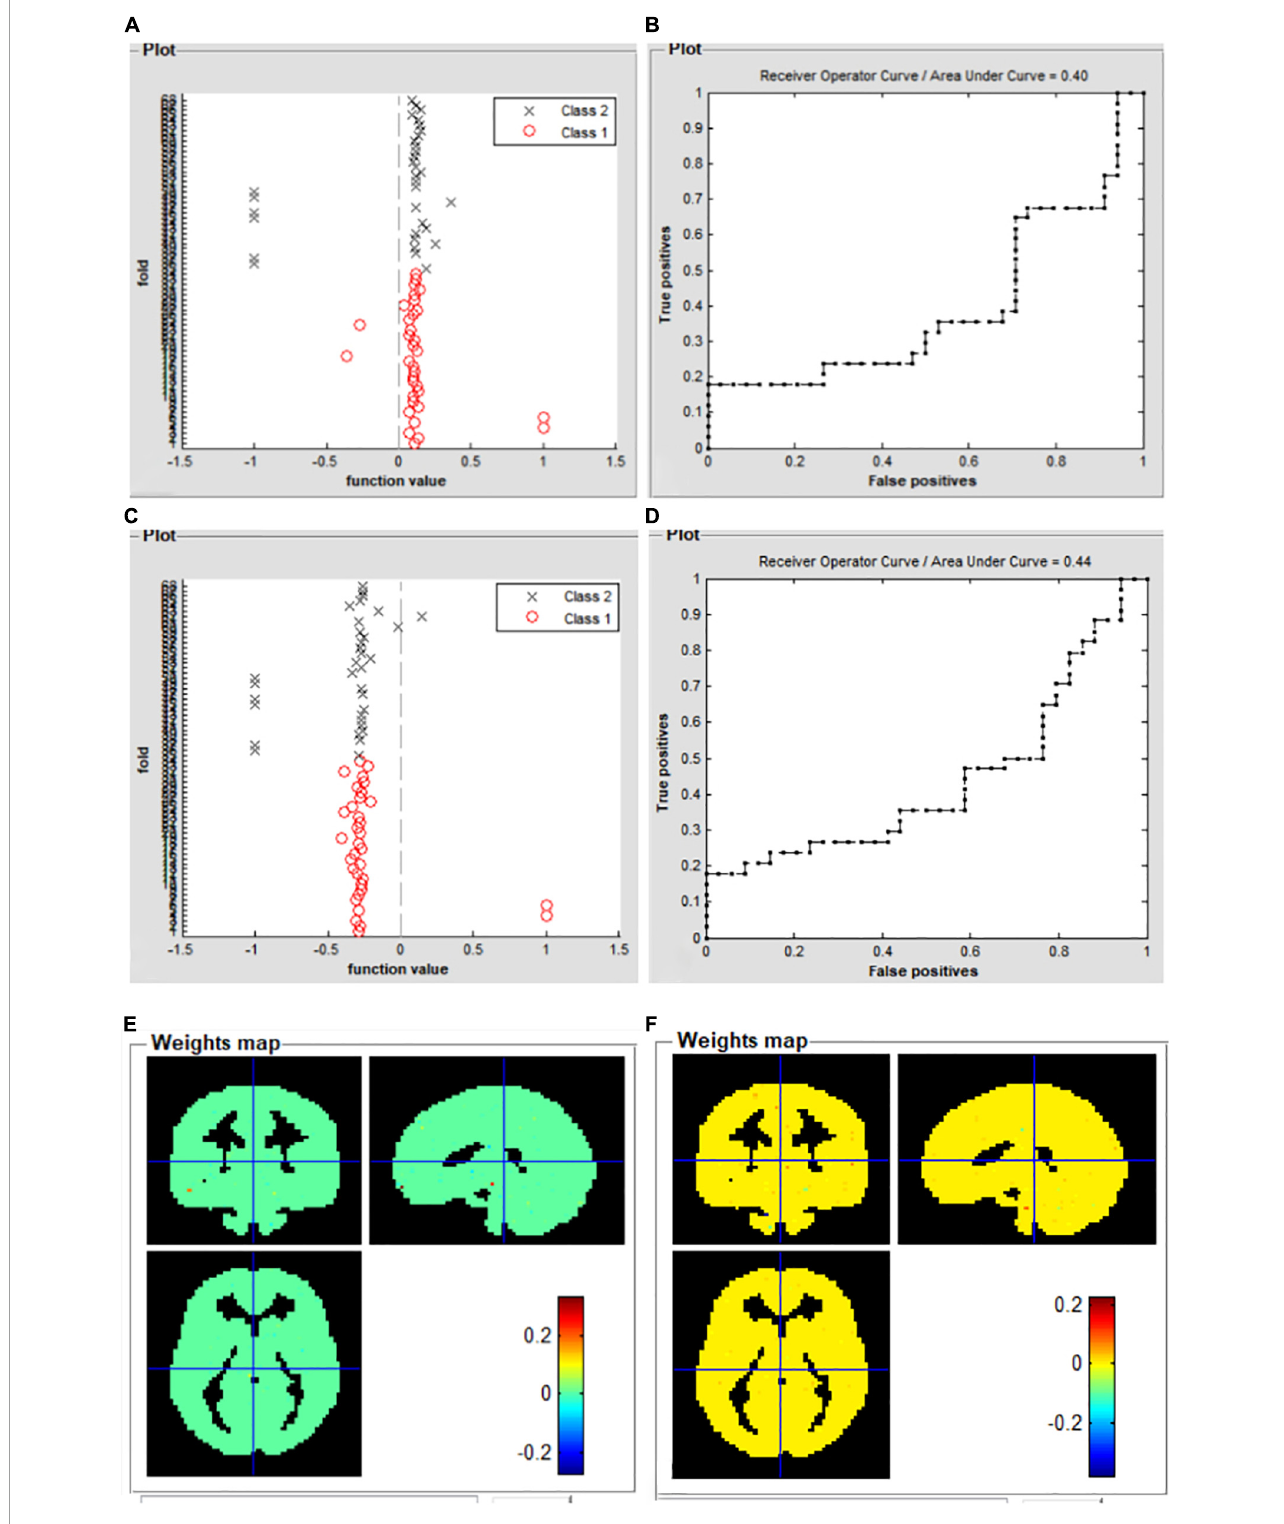
FIGURE3 Support vector machine classification results based on the mean dFC maps. Function dFC in left V1 value of SVM algorithm for two groups (class 1: PACG group; class 2: HC group) (A) ; the receive operating characteristic curve of the SVM classifier (B) ; function dFC in left V1 value of SVM algorithm for two groups (class 1: PACG group; class 2: HC group) (C) ; the receive operating characteristic curve of the SVM classifier (D) ; weight maps for SVM models for left V1 (E) ; weight maps for SVM models for right V1 (F) . PACG, primary angle-closure glaucoma; HC, health control; V1, primary visual cortex; dFC, dynamic functional connectivity; SVM, support vector